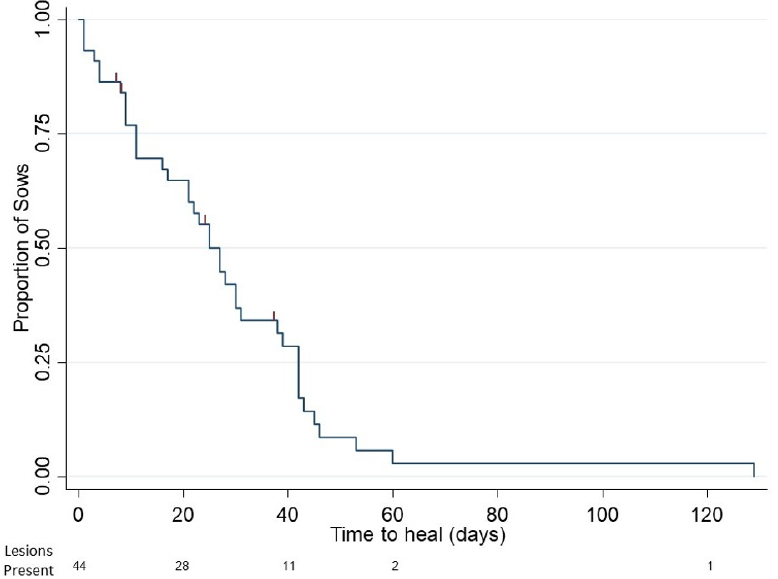
Figure 1. Kaplan–Meier survival estimates illustrating the day at which lesions resolved for 44 sows. Lesions were monitored from day 1 to healing. Healing was defined as the lesion no longer being visible. The median time to healing was 24 days. The number of lesions present at each time point is presented below the x -axis. Vertical marks represent sows removed prior to healing ( n = 4). Predicted maximum lesion size was 10.5 ± 3.2 cm 2 . There was a significant effect of day 1 lesion size on the maximum lesion size (IRR = 1.43 ± 0.13; p < 0.001). There was a significant effect of lameness at weaning with lame sows getting larger lesions (28.2 ± 11.8) compared to non-lame sows (10.5 ± 3.7) ( p < 0.001). Weaning BCS was also significant ( p < 0.001) with BCS 3 (24.1 ± 9.4) sows and BCS 4 (32.2 ± 11.8) sows having larger lesions than BCS 2 sows (6.6 ± 2.2) ( p < 0.01). Parity group also had a significant effect on lesion size ( p < 0.001) where parity group 3 (6.1 ± 2.4) had smaller lesions than parity group 1 (38.5 ± 19.3) ( p < 0.001) and 2 (40.2 ± 16.3) ( p < 0.001) as did parity group 4 sows (9.2 ± 3.4) ( p < 0.01). 3.4. Gestation Location and Posture There were no differences in the proportion of time that sows were found on solid flooring, slatted flooring, in the straw, or outside. There were also no differences in the proportion of observations where the sow was found standing up or in a sternal position (see Table 4). Table 4. Proportion of observations where sows with a shoulder sore (LES) and control sows (CON) were observed on different flooring types, in different areas in the gestation pen, in a sternal posi- tion, or standing up at the time of the observation. Sows were observed twice daily after 8 days post- weaning once they were placed in the gestation pen post-breeding. Proportions are means and standard deviations for slatted and solid flooring and are otherwise medians and interquartile ranges. Location or Posture